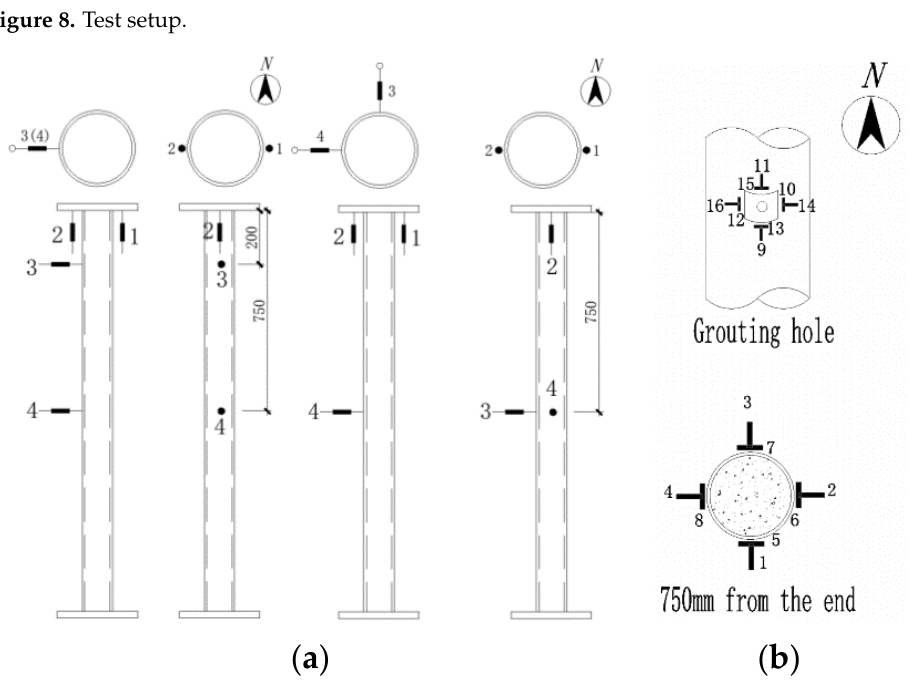
Figure 9. Arrangements of instrumentation. ( a ) LVDTs; ( b ) Strain